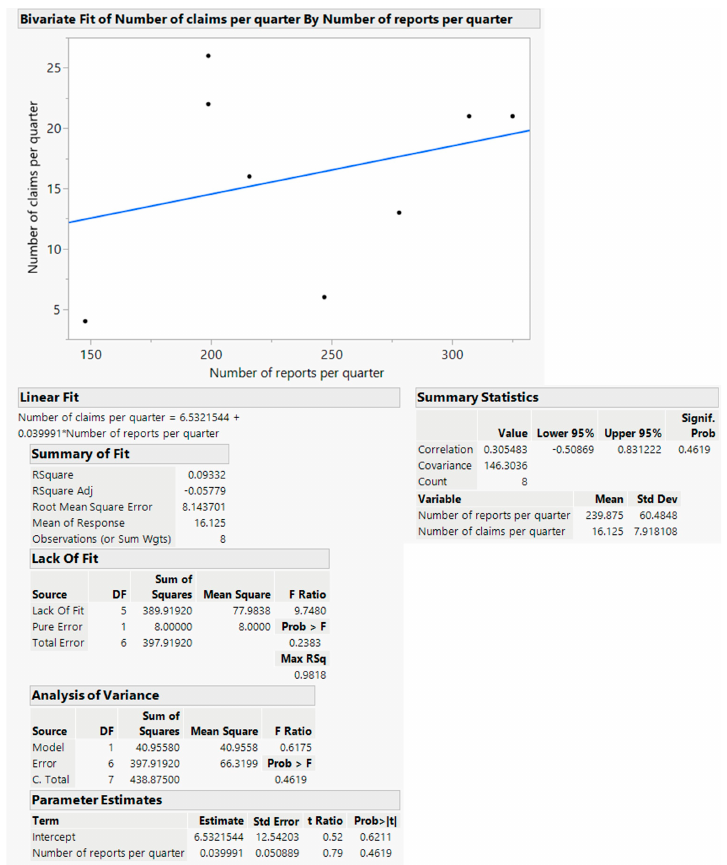
Figure 4. Number of claims versus number of reports.